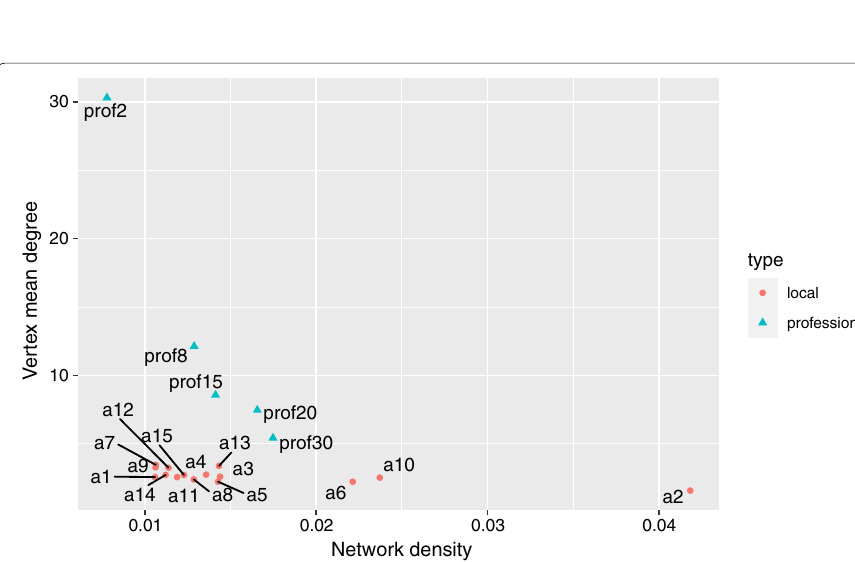
On the choice of binarization threshold value